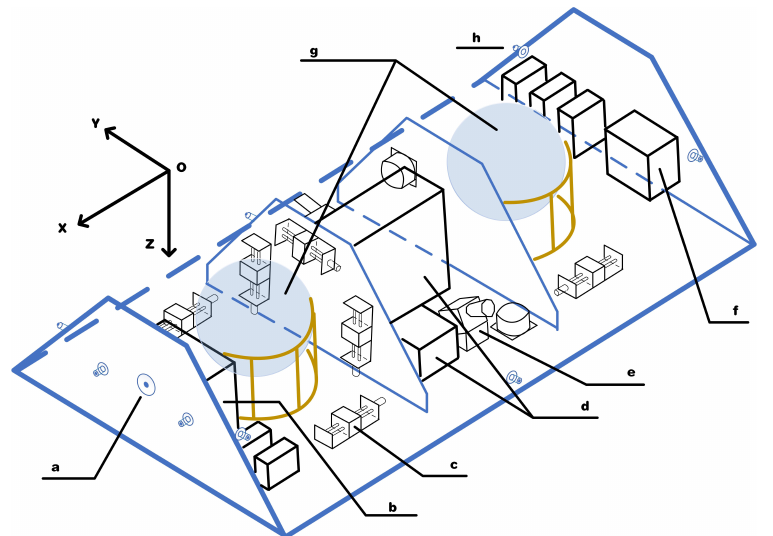
Figure 1. Structure of the satellite: ( a ) K-band antenna phase center; ( b ) K-band microwave ranging system payload; ( c ) centroid adjustment; ( d ) accelerometer for gravity field detection; ( e ) star sensor; ( f ) power supply; ( g ) fuel tank; ( h )